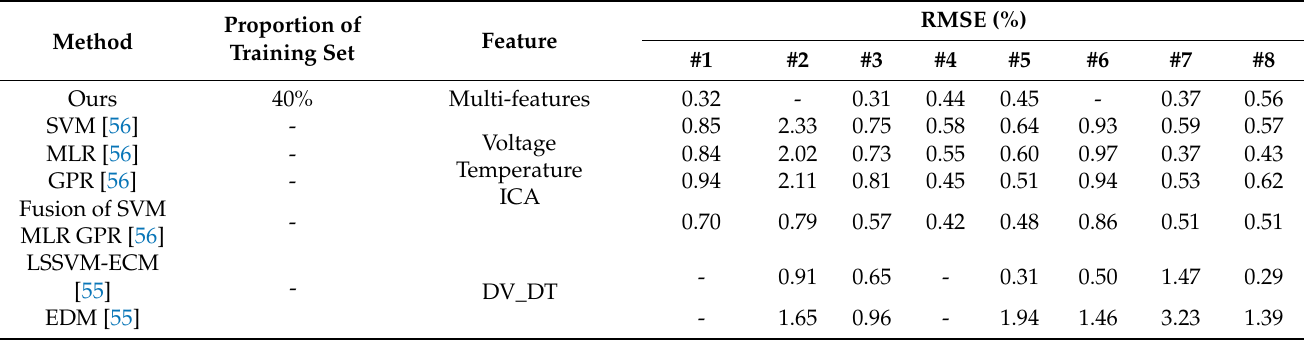
Table 6. RMSE of SOH estimation result on the Oxford